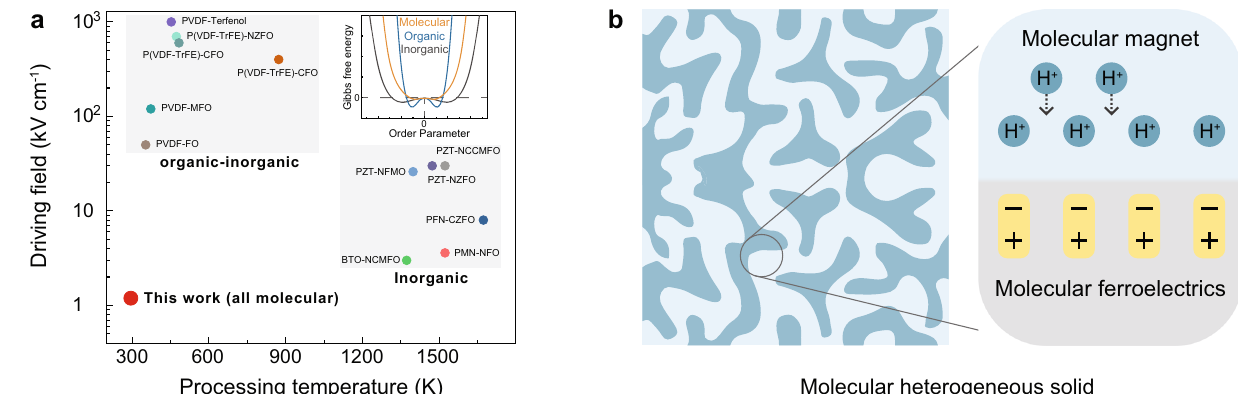
Fig. 1 Proton-mediated multiferroic molecular heterogeneous solid. a Selected multiferroic composites. Processing temperature is plotted against the driving fi eld (ferroelectric coercivity), as technological important parameters. The low driving fi eld in this work results from the primarily non-covalent bond (i.e., hydrogen bonding) in molecular ferroelectrics which is weaker than the strong ionic/covalent bonds in polymeric and inorganic ferroelectrics. Inset shows the schematic fi gure for the free energies of molecular, polymeric, and inorganic ferroelectrics 41 . P(VDF-TrFE)-NZFO [Ni 0.5 Zn0 .5 Fe 2 O 4 /poly (vinylidene fl uoride-tri fl uoroethylene)] 42 , PVDF-FO [poly (vinylidene fl uoride)-Fe 3 O 4 ] 43 , PVDF-Terfenol-D 44 , PVDF-MFO [MnFe 2 O 4 ] 45 ,